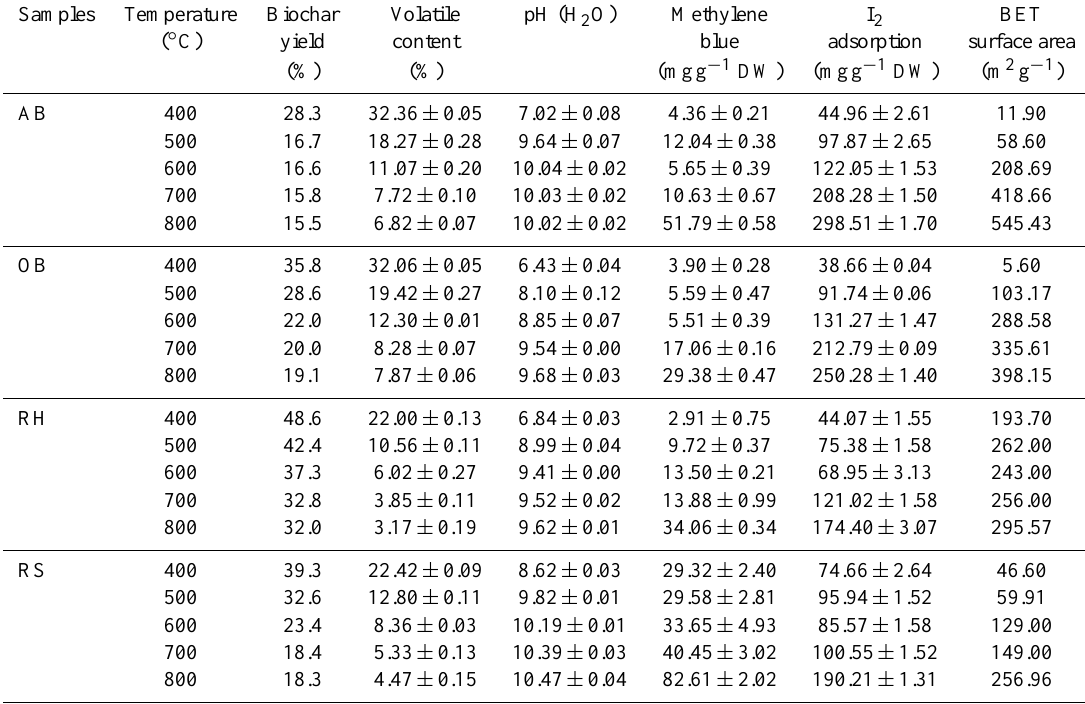
Table 1. Physical and chemical characteristics of the biochars derived from different feedstocks: apple tree branch (AB), oak tree (OB), rice husk (RH), and rice straw